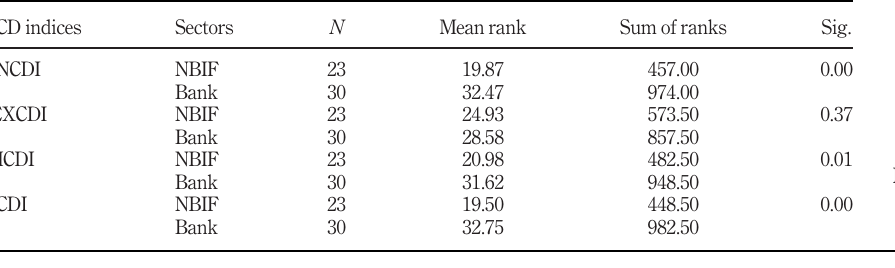
Table 6. Mann – Whitney U-